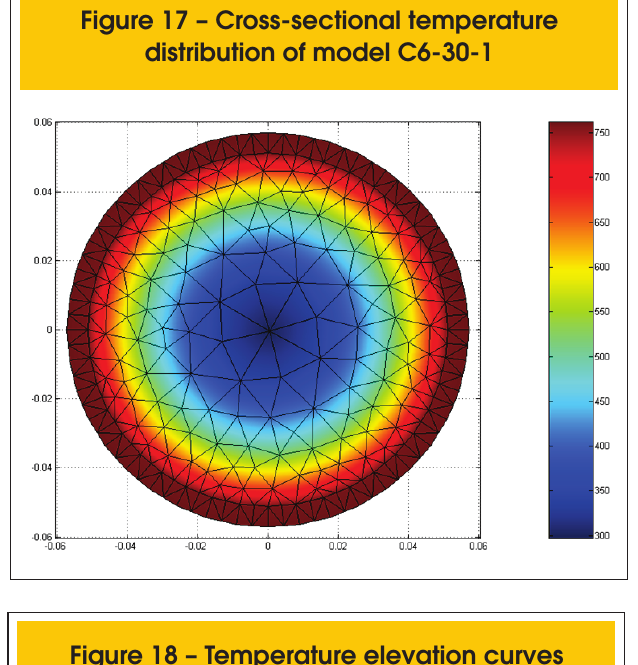
Figure 18 – Temperature elevation curves for the models with a 6-mm-thick tube and 30-minute exposure time